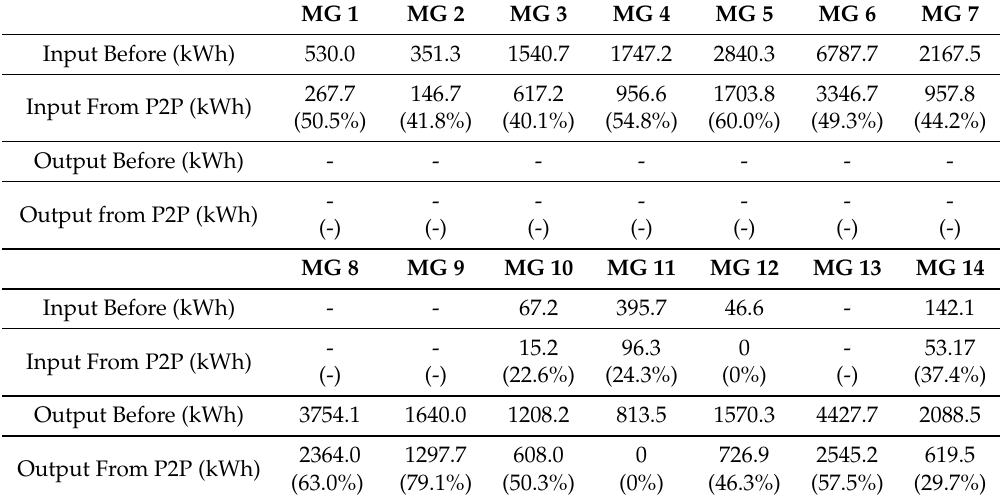
Table 2. Proportion quantity of traded energy from P2P energy trading.